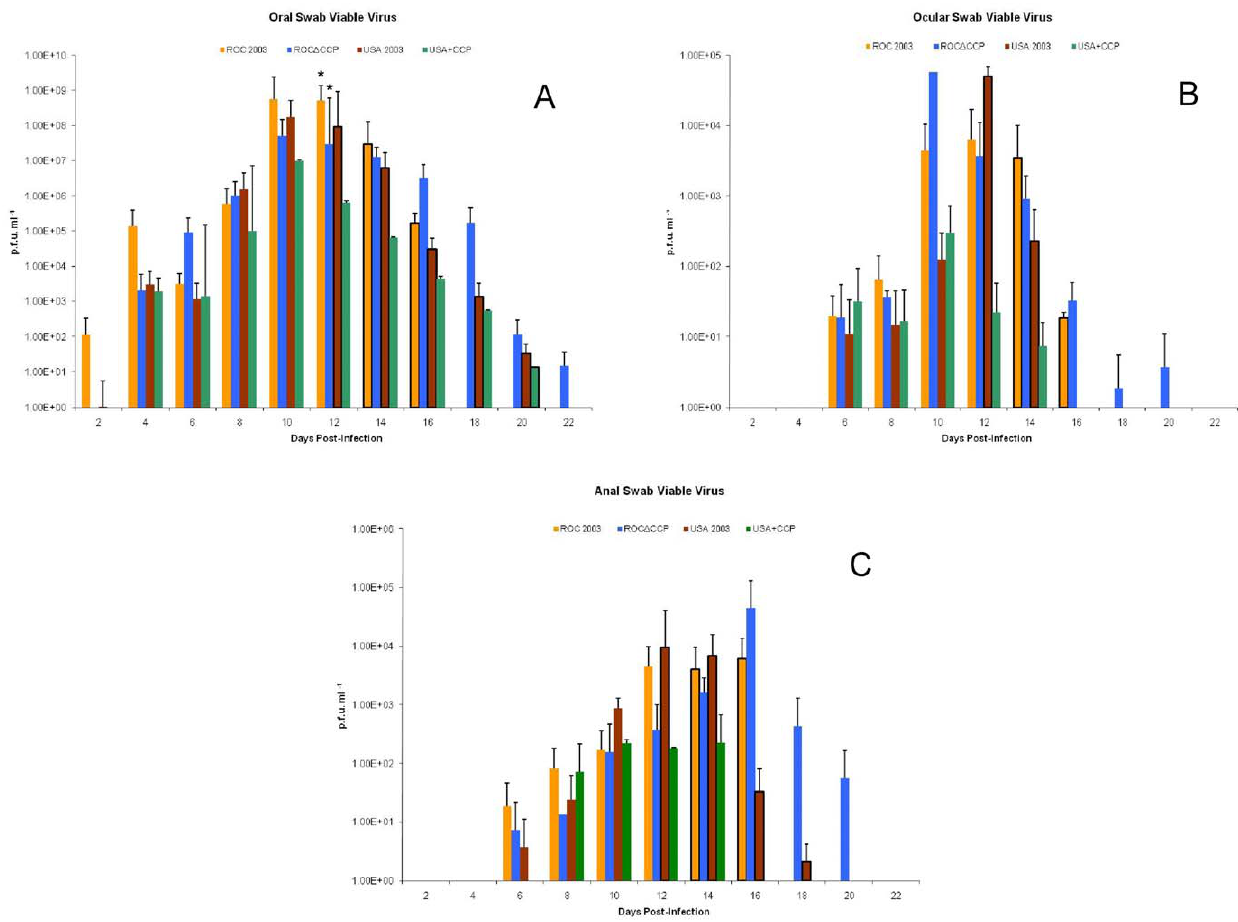
Figure 6. Viable monkeypox virus loads. Mean live virus titers for the oral (A), ocular (B), and anal (C) swabs taken from each animal in a given infection group in the prairie dog challenge study. Note that all animals in the ROC 2003 group were dead by day 16. Also, by day 16 there were only two remaining animals in the USA 2003 group and starting on day 20, there were only two remaining animals in the USA + CCP group. Dark bar borders indicate n , 4 for the mean generated on that day. The mean viral titer for each infection group was graphed with standard deviations. Unless indicated by an asterisk, group comparisons within sampling days were not significantly different (p . 0.05).